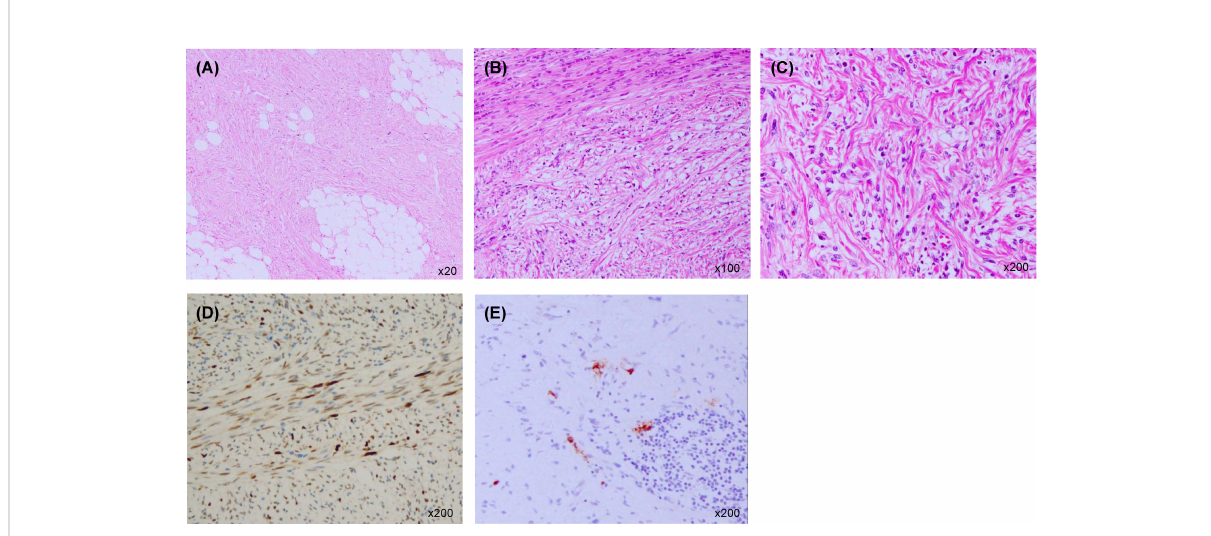
FIGURE 2 Histopathological examination of the right paratesticular mass. (A) Large adipocytes (haematoxylin and eosin staining ×20). (B) A bundle-like proliferation of medium-sized spindle-shaped cells interspersed with low-grade atypical adipoblasts (haematoxylin and eosin staining ×100). (C) Fibrosarcoma-like dedifferentiated liposarcoma (haematoxylin and eosin staining ×200). (D) Immunostaining positive for MDM2 (×200). (E) Immunostaining negative for S-100 protein